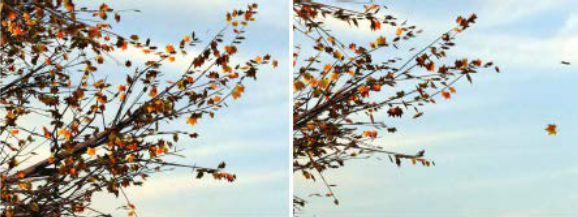
Figure 10. The leaves falling results of (Quigley, 2017) In addition, the trajectories of leaves fluttering defined in our method are basic processes, but the mixture model of them can adequately express the complex process of leaves falling in natural scene. The leaves falling trajectories of others methods, such as in (Li, 2015b), can be split into our three basic trajectories. As shown is Figure 11, Li et al. (Li, 2015b) divided leaf falling motions into 6 classes, including steady descent, periodic tumbling, transitional chaotic, periodic fluttering, transitional helical, and periodic spiral. While these motions are all composed of rotation, roll and screw roll, as shown in Figure 4. Thus, our trajectories can not only descript the dynamic characteristics of leaves, but also provide the simulation reference for the further development of falling leaves.